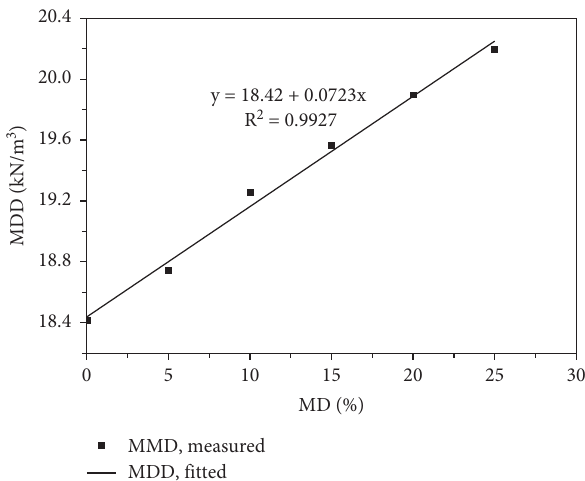
Figure 8: Variation of MDD with the percentage of MD.